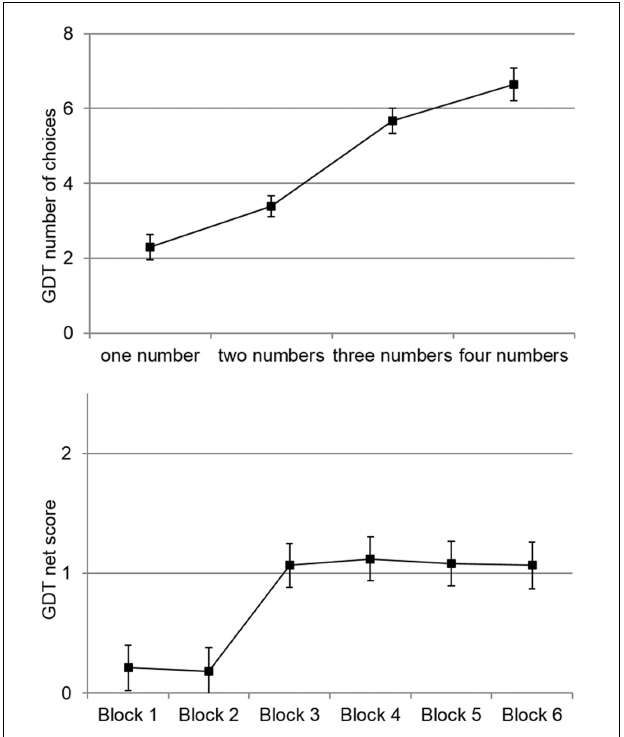
FIGURE 2 | Descriptive values of GDT behavior. Top : Mean number of choices for the four risk alternatives. Bottom : Course of behavior over the task’s duration with regard to net score (number of low risk choices—number of high risk choices) in six blocks á three decisions. Error bars are standard